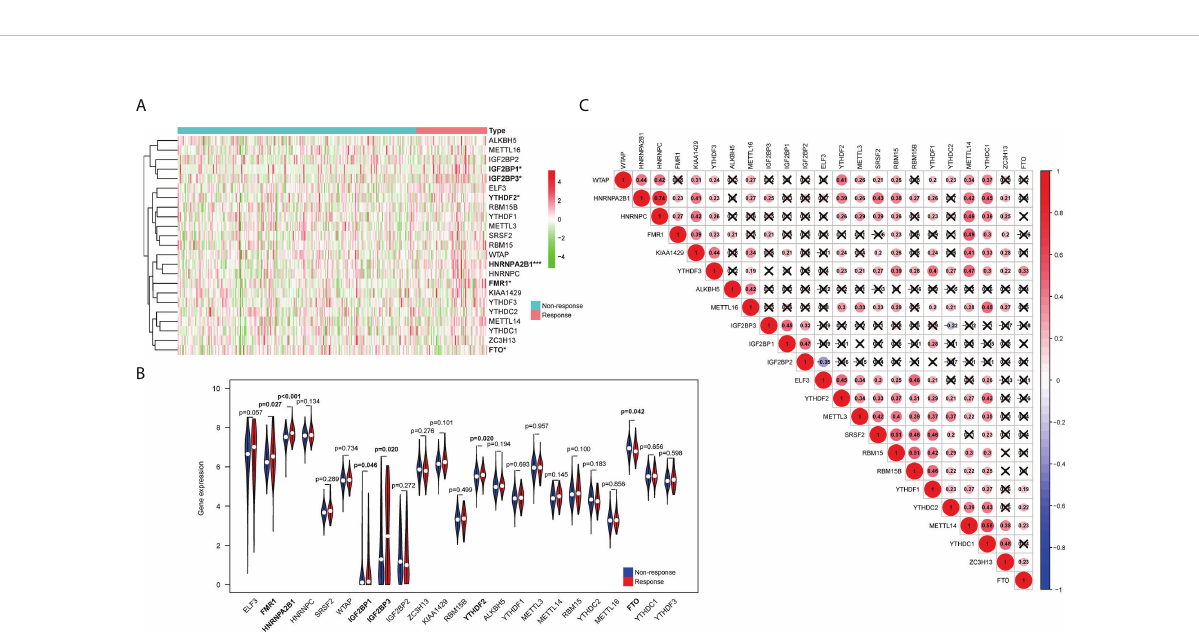
FIGURE 1 Relationship between the expression of m6A RNA methylation regulators and treatment response in urothelial carcinoma patients. (A) The heatmap shows the expression patterns of the 23 m6A methylation regulators between the response group and non-response group. (B) The violin plots exhibit the differential expression of the 23 m6A methylation regulators in the response group (red) and the non-response group (blue). (C) Spearman correlation analyses of the expression of the 23 m6A methylation regulators. *P < 0.05, ***P < 0.001.